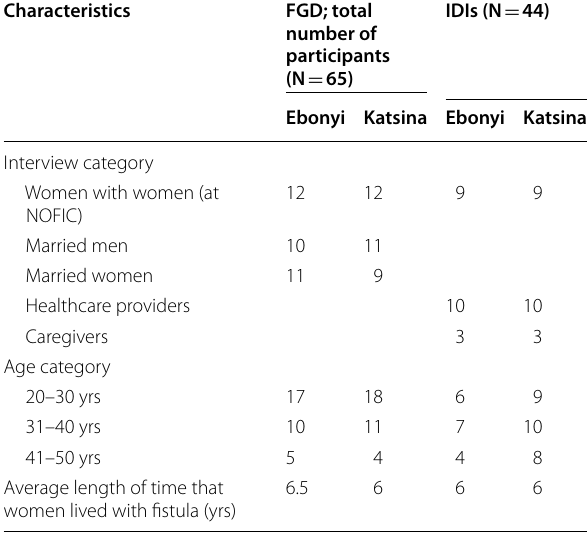
Table 1 Demographics Characteristics of the Participants